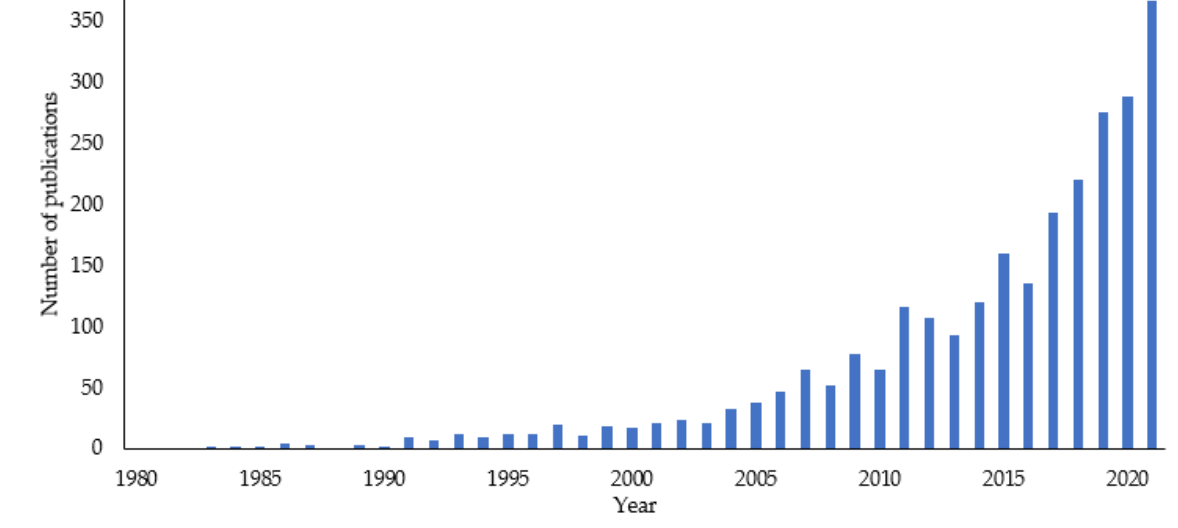
Figure 1. The number of papers on rice remote sensing published in journals from 1980 – 2021.